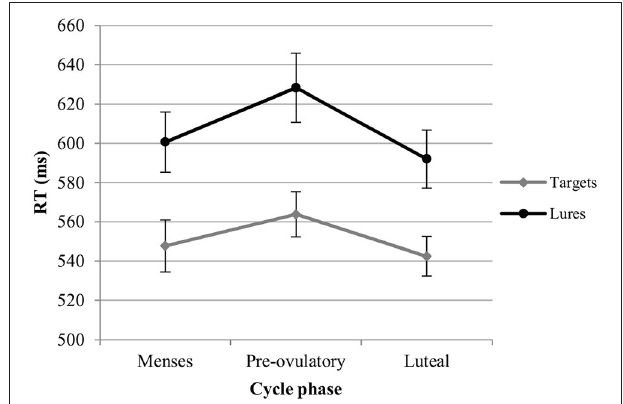
FIGURE 3 | Reaction time (RT) for the N-back task along the menstrual cycle. Responses were significantly faster in the luteal phase compared to pre-ovulatory phase for both targets and lures.